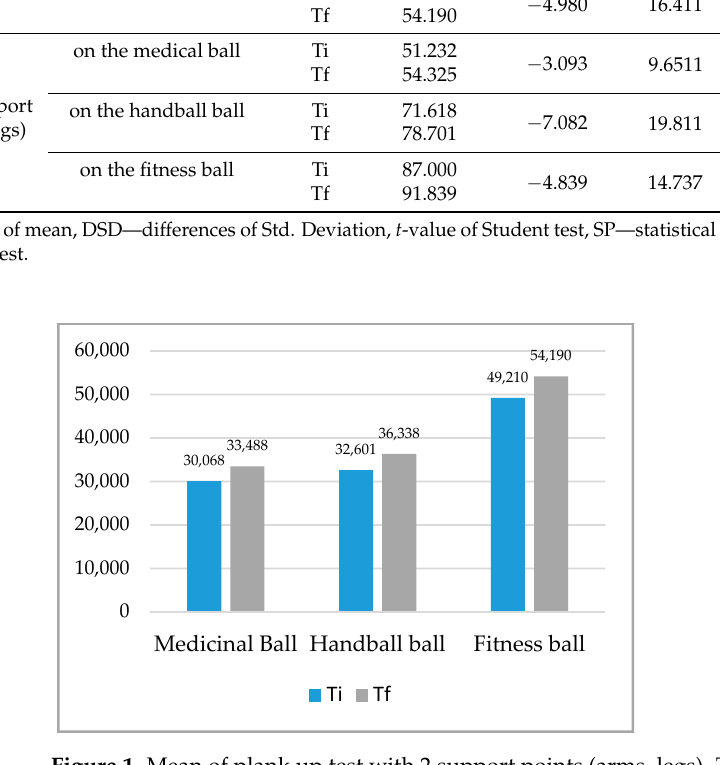
Figure 1. Mean of plank up test with 2 support points (arms, legs). Ti—initial test; Tf—final test.